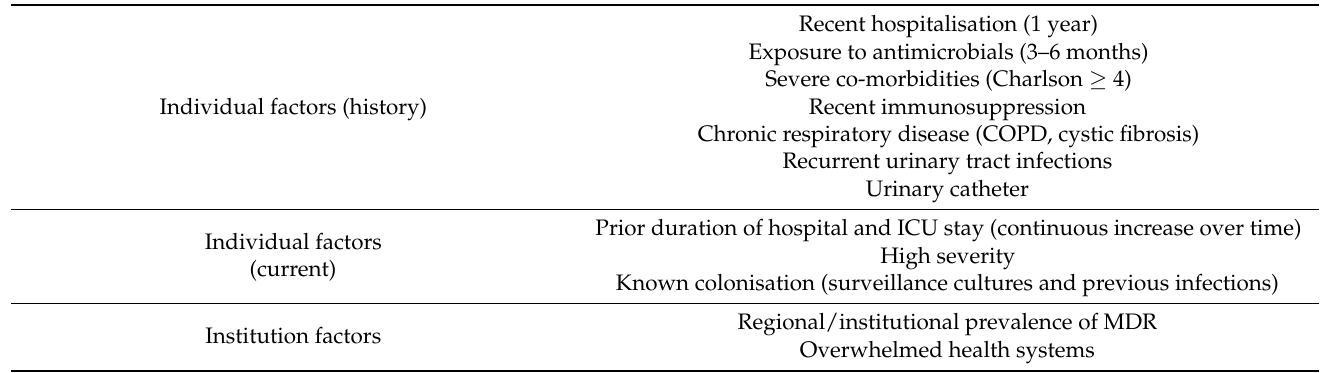
Table 2. Risk factors for multidrug-resistant